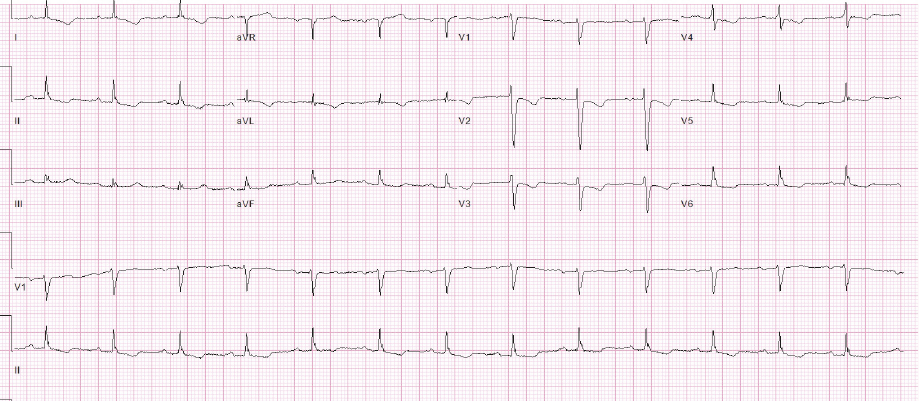
Figure 2: EKG shows normal sinus rhythm with heart of 86 bpm and new T inversions in V1 to V4.